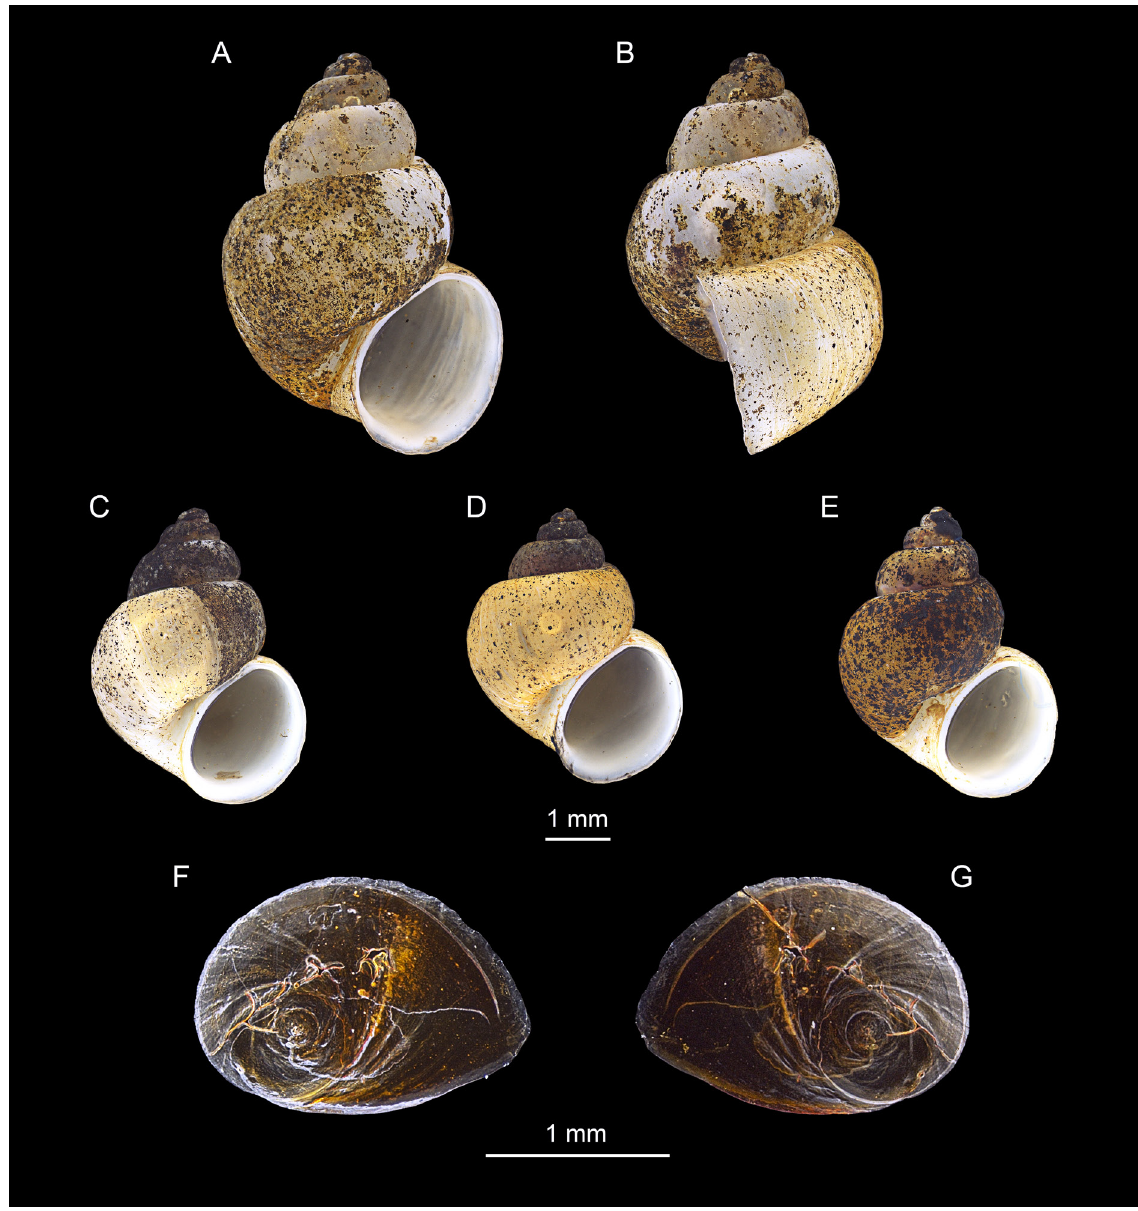
Fig. 15. Shells and operculum of Mercuria maceana (Paladilhe, 1869) from C’an Tunis, Barcelona, Spain. A–E . Shells. F . Operculum, inner side. G . Operculum, outer